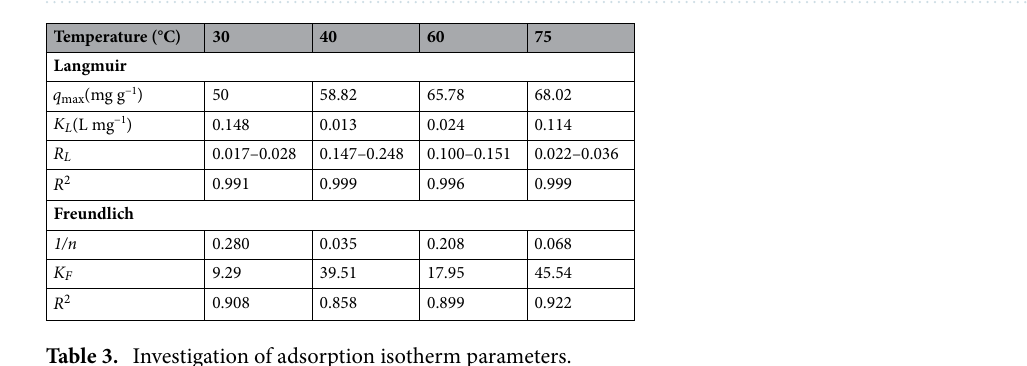
Figure 8. Investigation of adsorption kinetics.